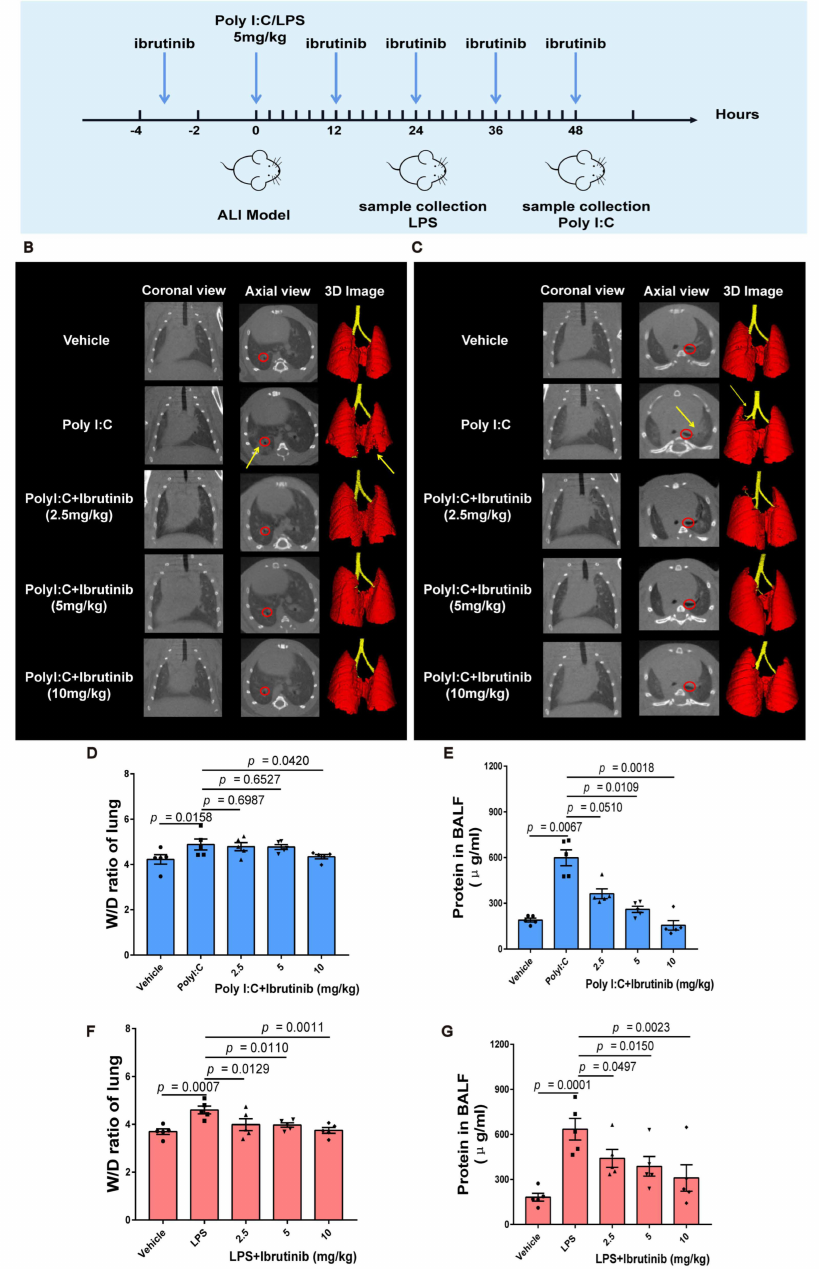
Figure 1. Ibrutinib protected against poly I:C- and LPS-induced acute lung injury in mice. ( A ) Schematic presentation of the experimental procedures. ( B ) Representative coronal, axial micro-CT views, and 3D lung reconstructions of the mice challenged with the vehicle, poly I:C and poly I:C plus ibrutinib (2.5, 5, and 10 mg/kg) for 48 h. ( C ) Representative coronal, axial micro-CT views, and 3D reconstructions of the lungs of mice challenged with the vehicle, LPS, and LPS plus ibrutinib (2.5, 5, and 10 mg/kg) for 24 h. ( D ) Lung tissue W/D ratios after 48 h of poly I:C challenge. ( E ) Total protein concentrations in the BALF from the poly I:C-challenged groups. ( F ) Lung tissue W/D ratios after 24 h of LPS challenge. ( G ) Total protein concentrations in the BALF from the LPS-challenged groups. Values are shown as means ± SEM for n =